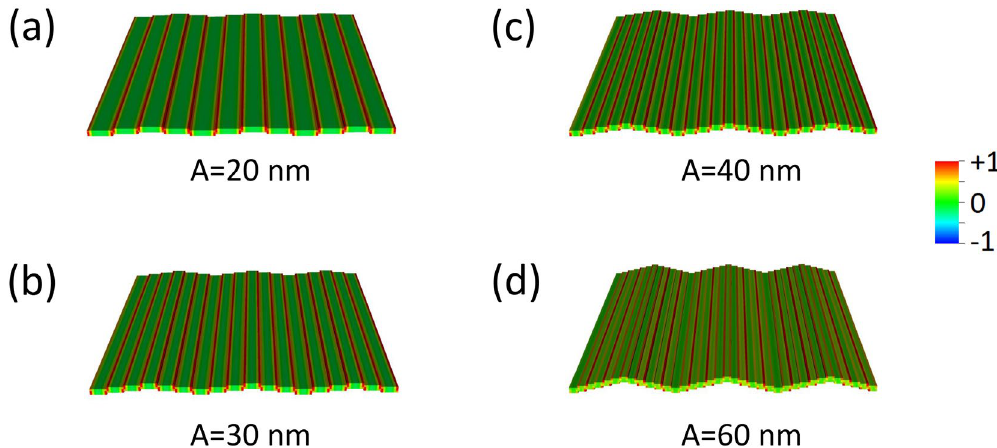
Figure 10. Edge mode phase profiles (real z-components, in arbitrary units) for: (a) 4-stripe system; (b) 6-stripe system; (c) 8-stripe system; (d) 12-stripe system (the undulation amplitude A is indicated). Edge mode occur only in the configuration M (cid:31) x and only in a non-uniform magnetization (hence, A = 0 is absent).